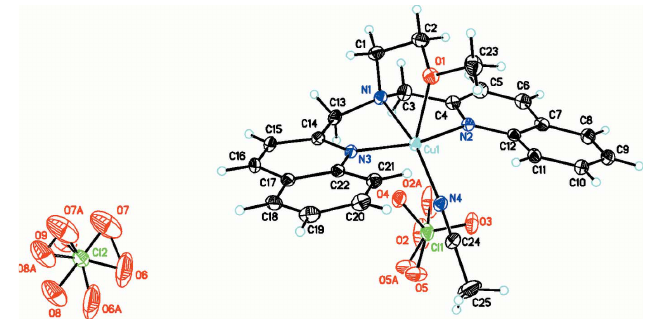
Figure 1 Structure of the title compound, [Cu(DQMEA)(CH 3 CN)](ClO 4 ) 2 , with atom labels, shown with displacement ellipsoids drawn at the 30% probability level. Both perclorate anions are disordered, with oxygen occupancy ratios of 0.900 (10):0 l.100 (10) and 0.779 (16):0.319